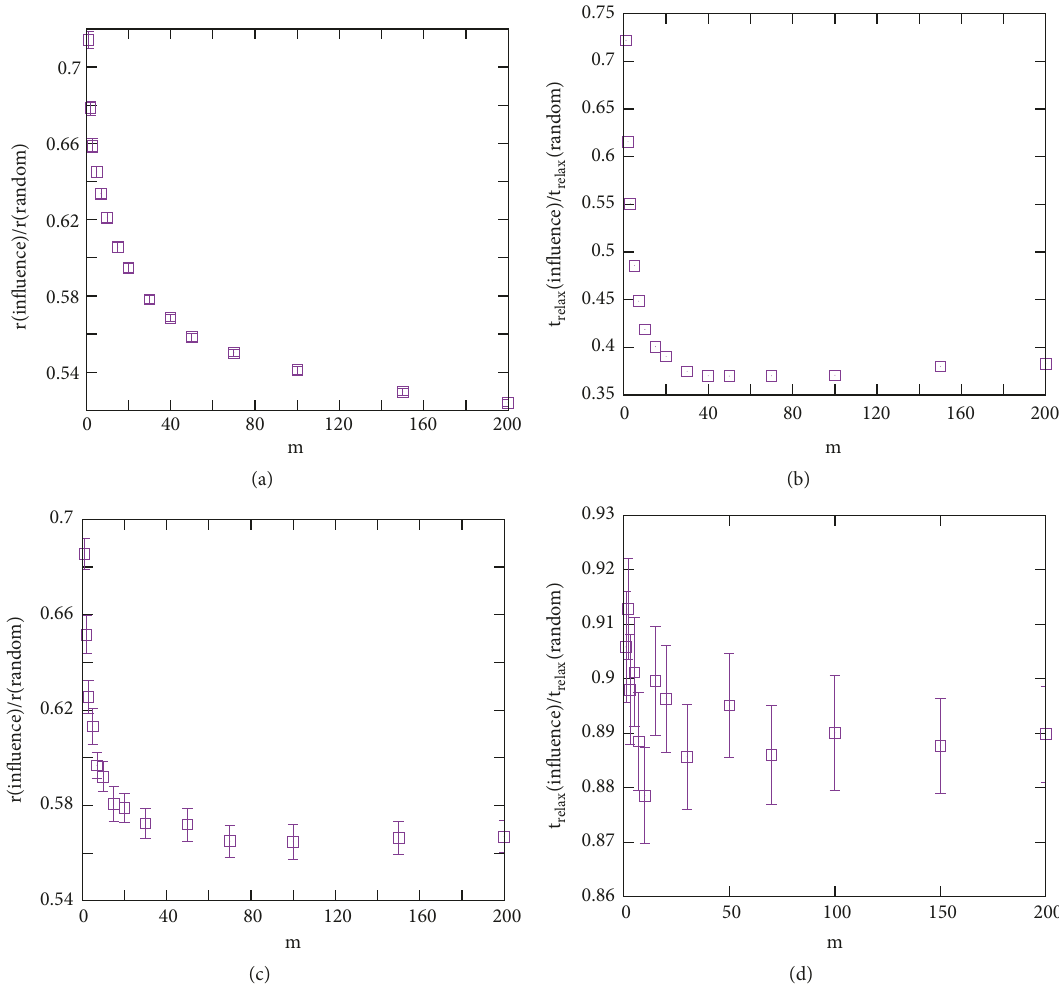
Figure 3: Dependence of ((a), (c)) the average relative opinion dispersion 푟 and ((b), (d)) average relative relaxation times on the intensity of influence maximization (measured by the number of attempted optimization steps 푚 per update) for the scenario of a network of all agents attempting to maximize their influence on the system (top) and a scenario of two external agents with opinions 푥 = ±1 attempting to maximize their influence on the system. Results are averaged over 50 independent runs for a system of 푁 = 1000 nodes, noise Δ = 0.001 , and ⟨푘⟩ = 10 . In the scenario of external influencers each controls 푘 ext = 509